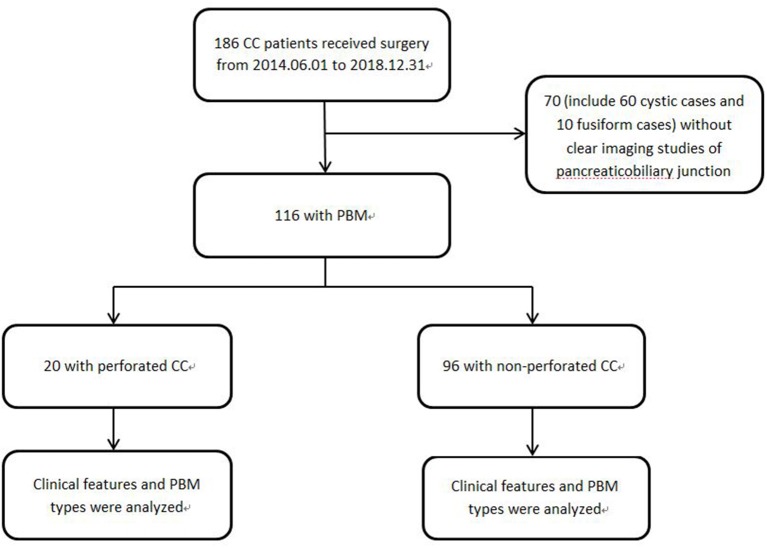
Study profile 70 patients who could not be found clear PBM images either in MRCP nor in IOCP were excluded.